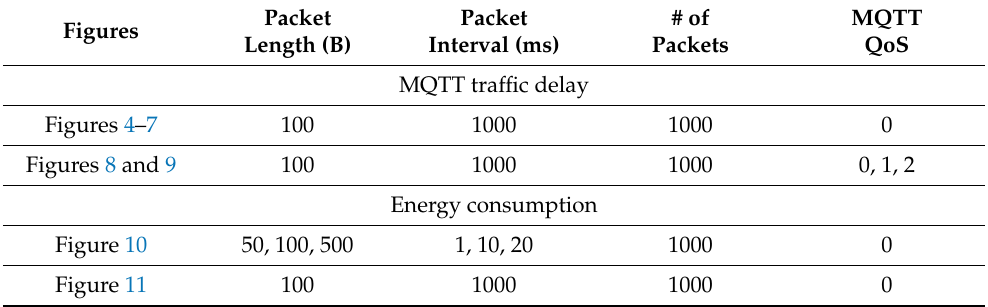
Table 3. Testbed